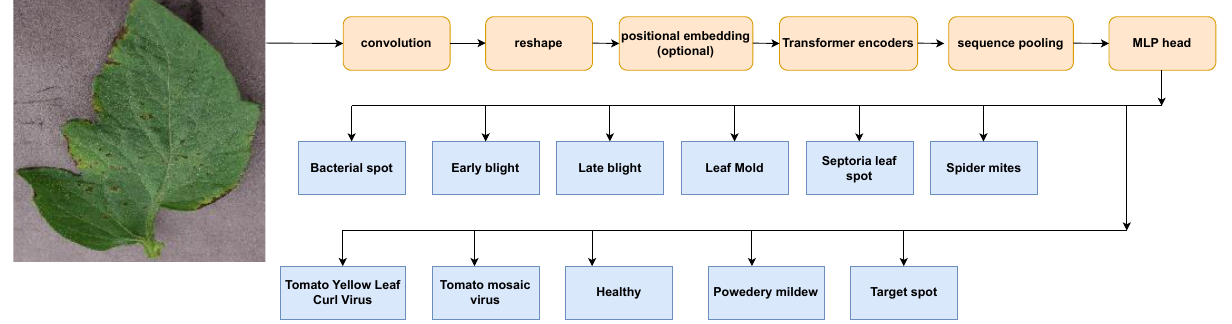
Figure 6. Compact Convolutional Transformer (CCT) used as